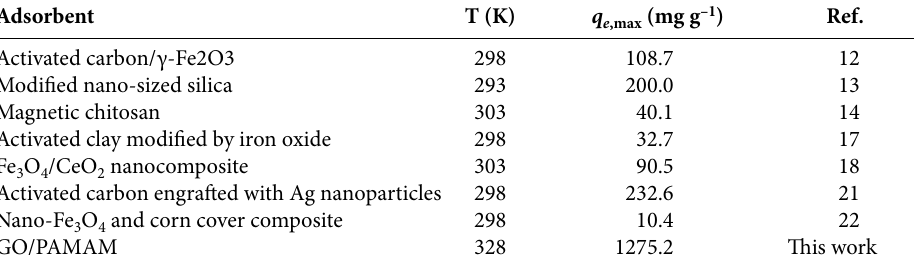
Table 1. Maximum adsorption capacity ( q e ,max ) of ARS on a series of